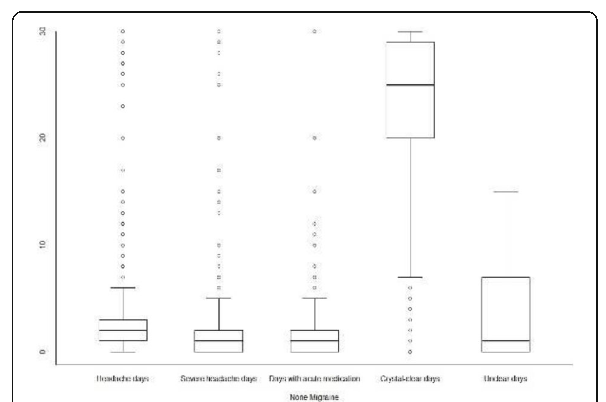
Fig. 2 (abstract P137). See text for